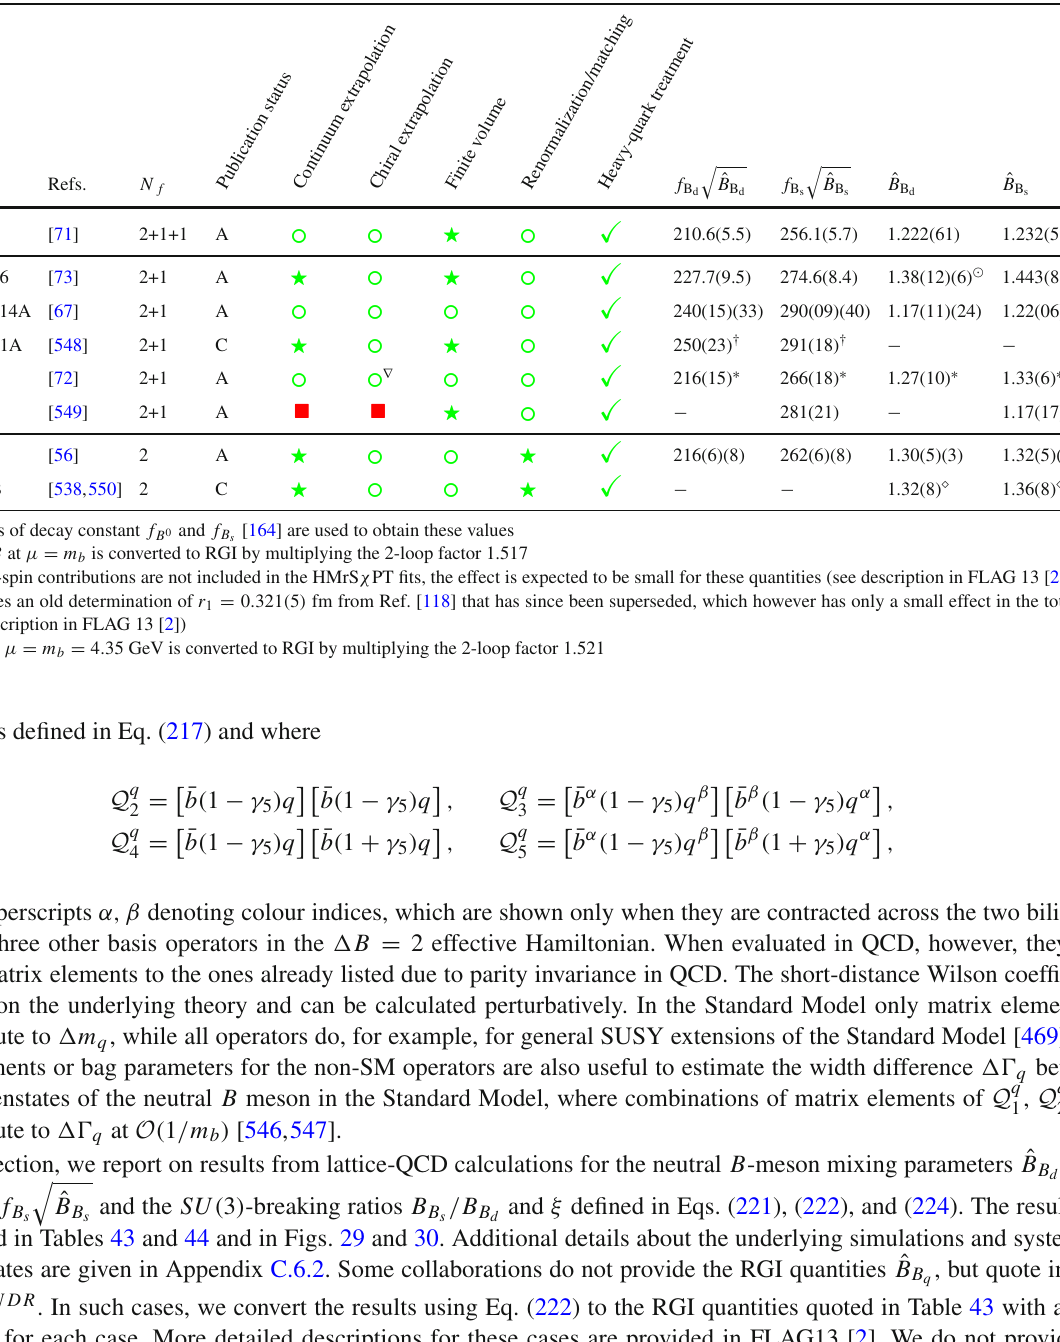
Table 43 Neutral B - and B s -meson mixing matrix elements (in MeV) and bag parameters